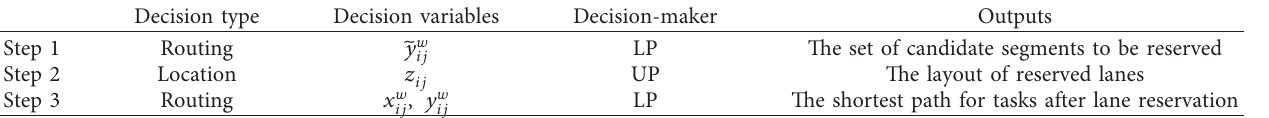
Table 1: Systematic description of the resolving approach of BHLRP.